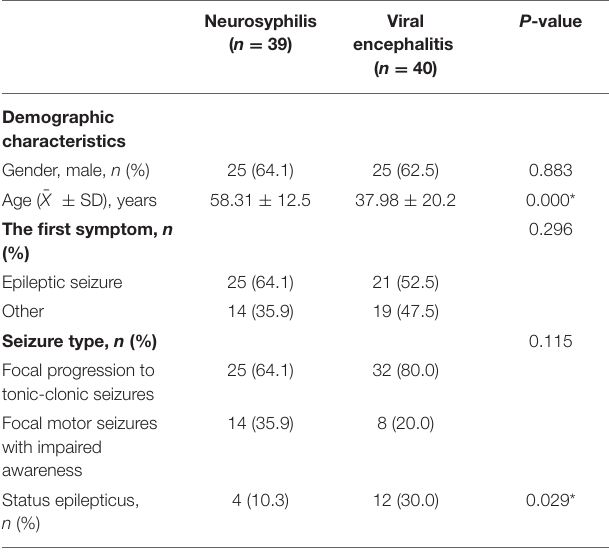
TABLE 1 | Comparison of clinical characteristics of patients with seizures caused by neurosyphilis and viral